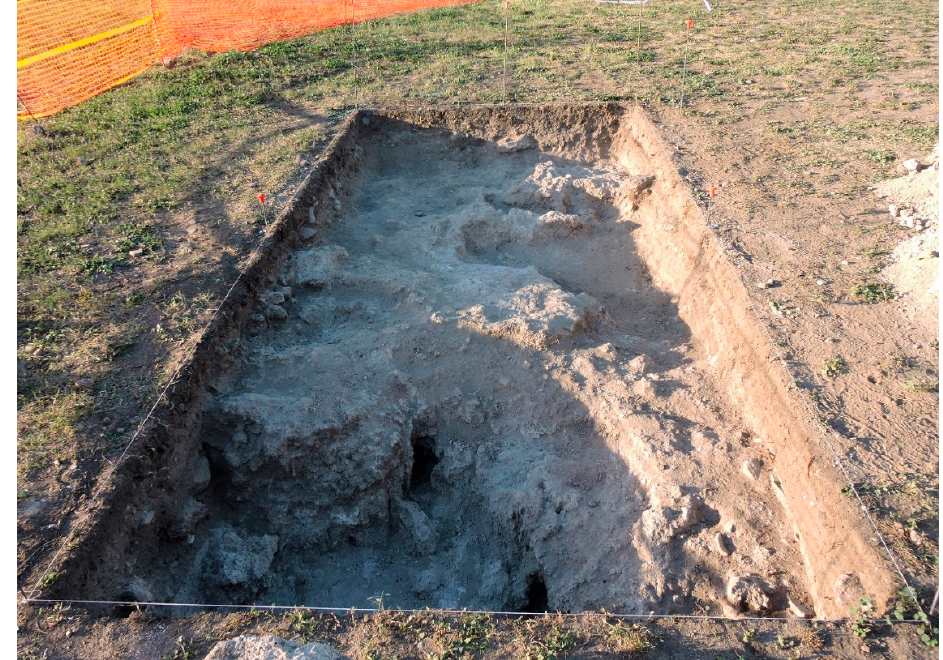
Figure 17. Photo of the stratigraphical survey No. 243 trench excavation.